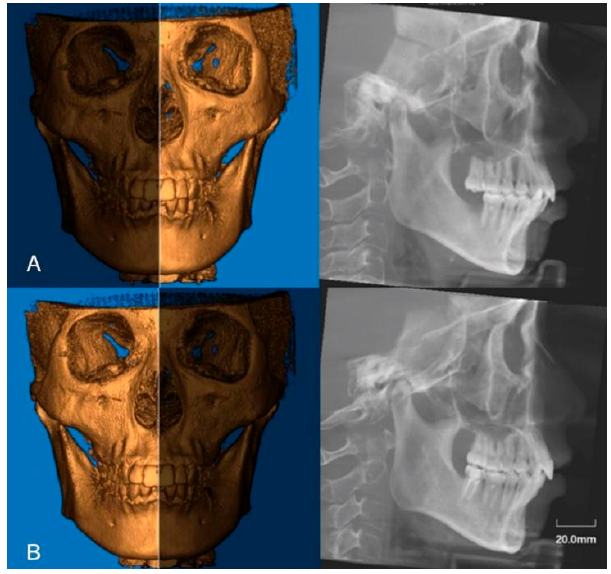
Figure 3. Lateral cephalometric radiographs were constructed from left side ( A ) and right side ( B ), respectively.